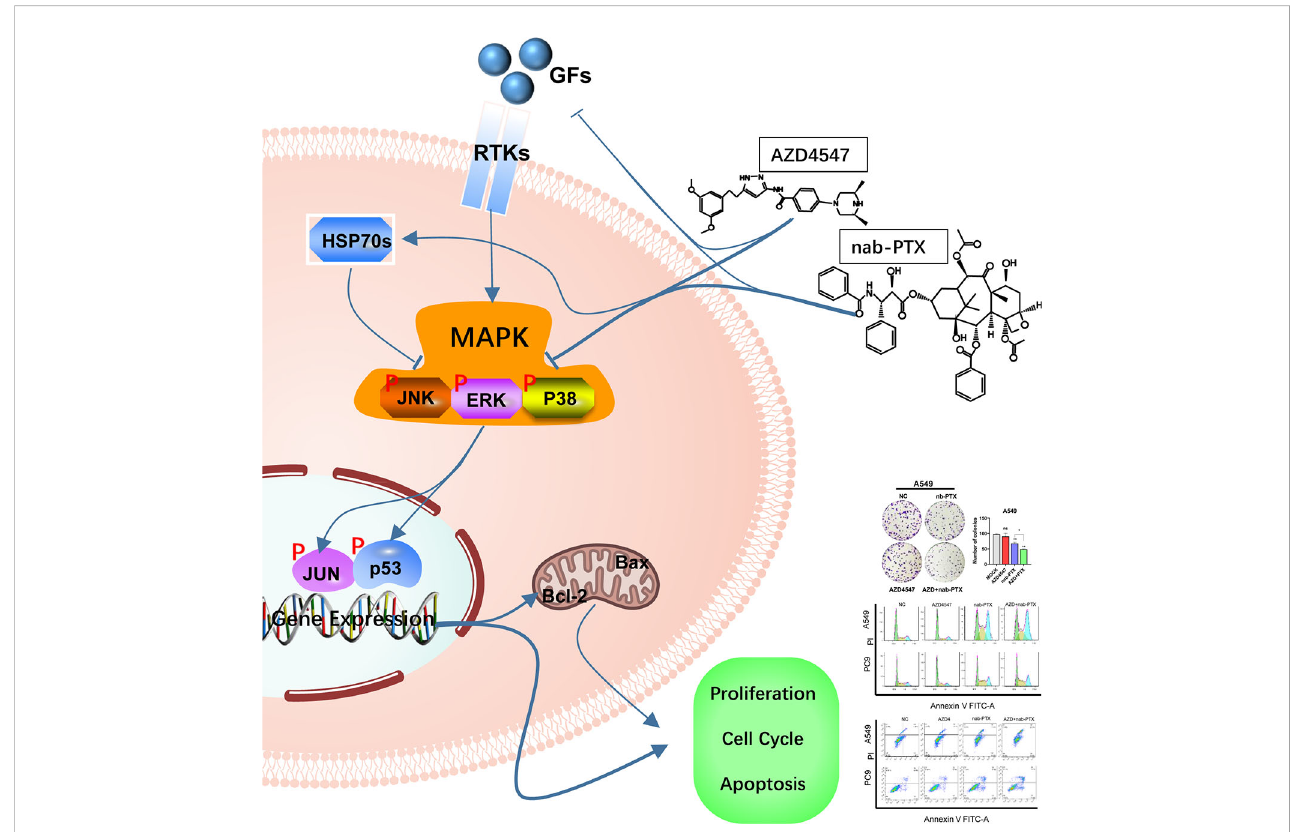
FIGURE 7 The combination of AZD4547 and nab-PTX inhibited cell proliferation, led to cell cycle arrest in the G2/M phase, promoted apoptosis, and exerted a synergistic antitumor effect by suppressing phosphorylation of MAPK signaling pathway components (GFs, growth factors; RTKs, receptor tyrosine kinases; HSP70s, heat shock 70 kDa